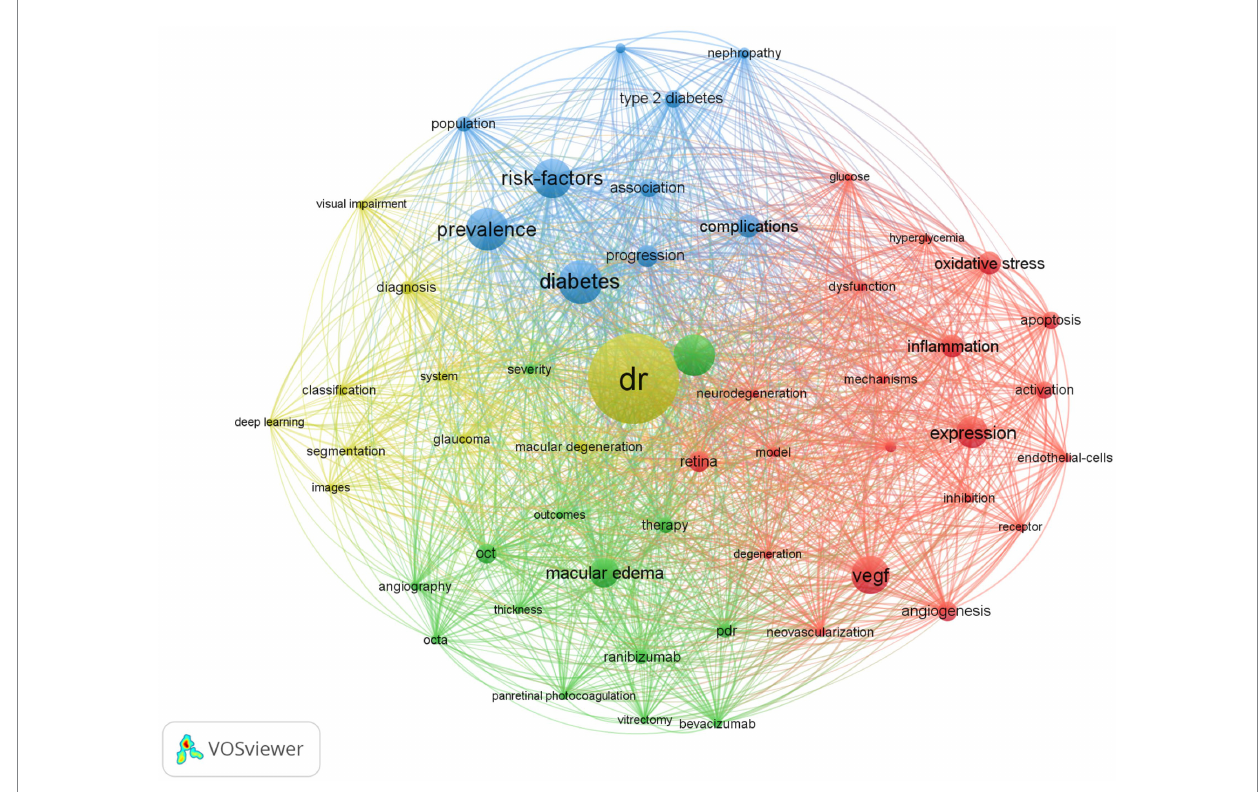
FIGURE 3 Bibliometric analysis of the keywords on DR. The node size represents the frequency of keyword occurrence, and the line represents the co- occurrence relationship. The same color is the keyword of the same cluster